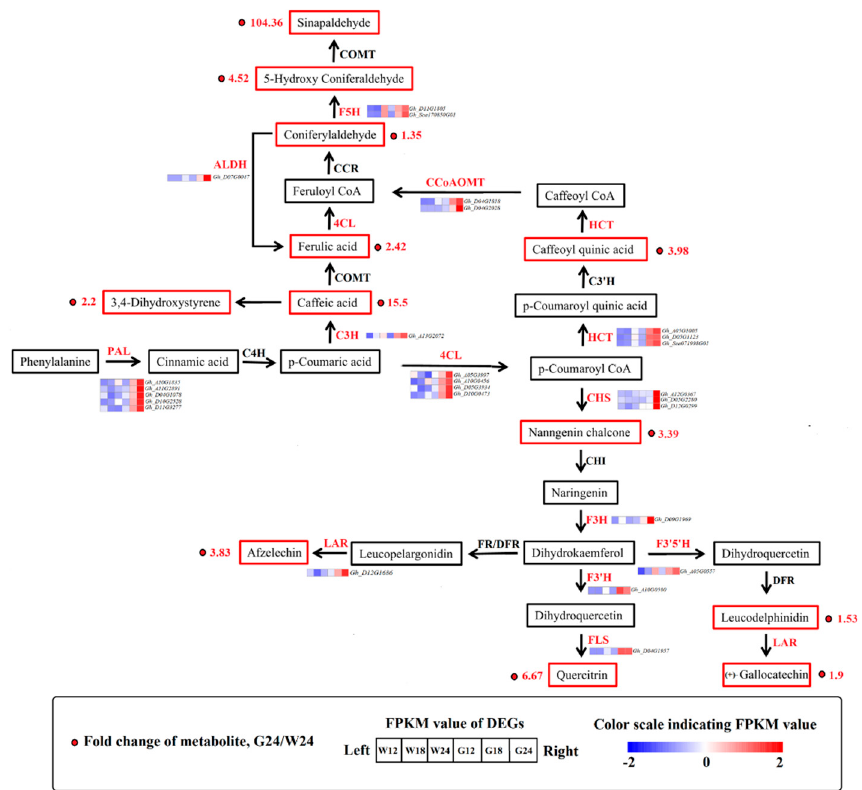
Figure 6. Transcript and metabolic profiling of genes in the phenylpropanoid and flavonoid biosynthetic pathways in cotton. PAL , phenylalanine ammonia-lyase; 4CL , 4-coumarate CoA ligase; C3H , cinnamate 3-hydroxylase; ALDH , Aldehyde dehydrogenase; HCT , shikimate O-hydroxycinnamoyltransferase; CCoAOMT , ca ff eoyl-coenzyme A O-methyltransferase; CHS , chalcone synthase; F3H , flavanone 3-hydroxylase; F3 (cid:48) H , flavanoid 3 (cid:48) -hydroxylase; DFR , dihydroflavonol 4-reductase; FLS , flavonol synthesis; LAR , leucocyanidin reductase. Table 4. List of the phenylpropanoid pathway genes.